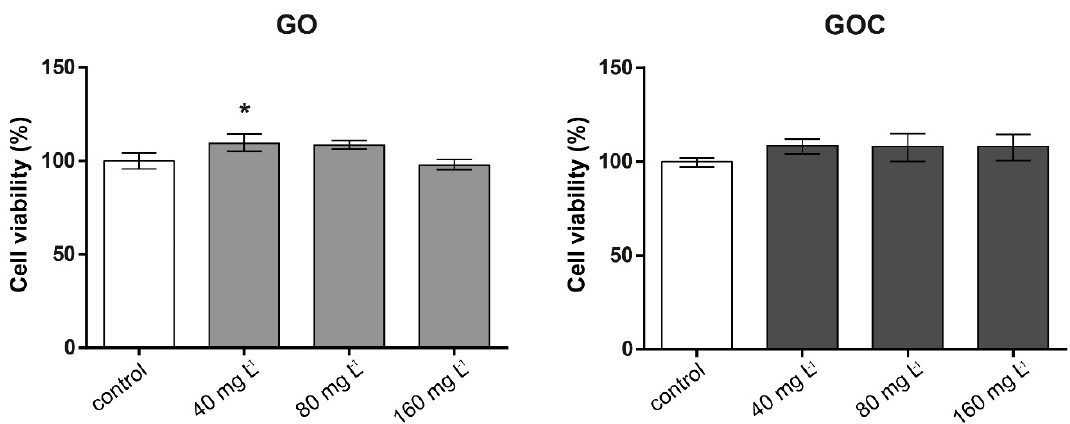
Figure 3. Viability of A549 cells (neutral red assay) treated with di ff erent concentrations of GO ( left ) and GOC ( right ). Results are expressed as % of control (untreated cells). Data represent the mean ( ± standard deviation, SD) of three independent replicates. Di ff erences were established using a one-way ANOVA followed by Dunnett post hoc test to compare every mean with the control, and considered significant at p ≤ 0.05. * p ≤ 0.05.